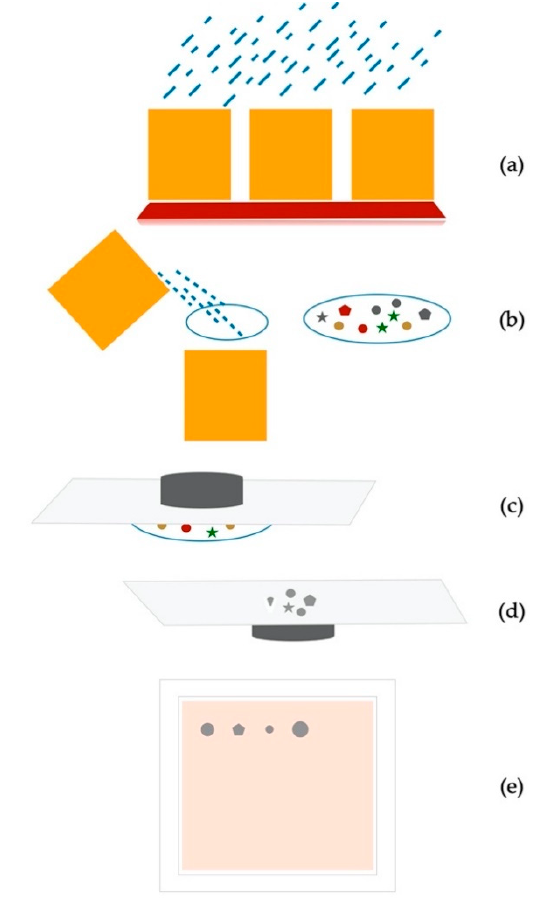
Figure 2. Atmospheric particle collection. Precipitation was collected in buckets placed on the roof tops ( a ); and filtered through laboratory-grade filter paper ( b ); particles were collected by slowly moving a magnet taped to a glass slide over the dried filter paper ( c ); collected particles were isolated, observed under a visible light microscope, and selected according to the diameter, shape, and texture consistent to micrometeorites ( d ) [1,24]; selected particles were mounted between 5- μ m-thick polypropylene sheet stretched on a cardboard frame and held in place by a thin layer of petrolatum ( e ). The cardboard holder allowed them to be analyzed at different beam lines.